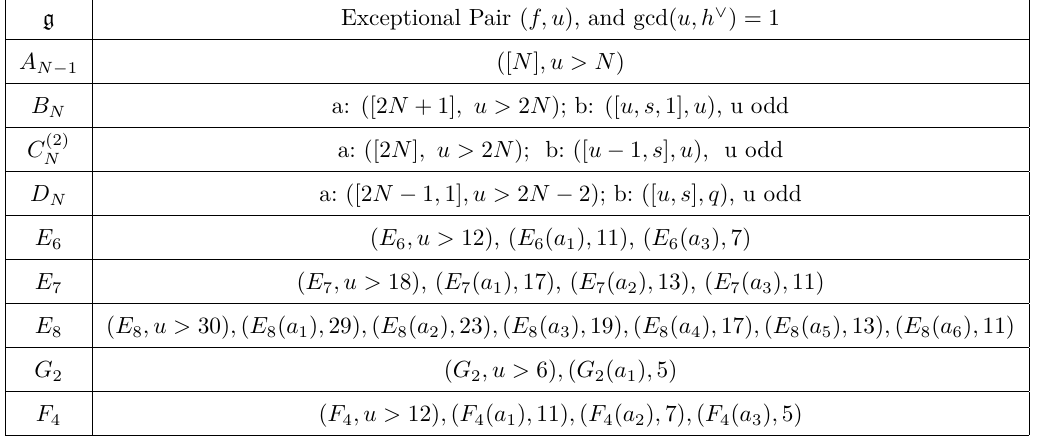
Table 8 . List of lisse VOA with the form W k 2 d ( g , f ) where f is a nilpotent orblit labelling a regular singularity with no mass deformation . u specifies the irregular singularity. The level k corresponding 2d VOA is k = − h ∨ + h ∨ . These pairs give rise to 4d N = 2 SCFTs T [ W k 2 d ( g , f )] u with no Higgs